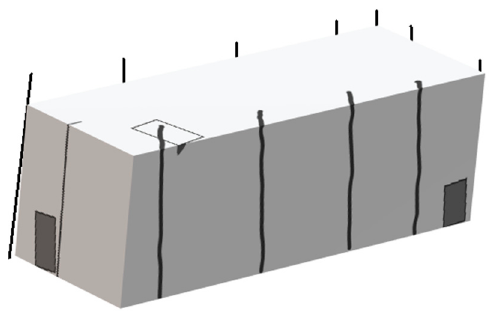
Figure 5. Illustration of Salish plank house.